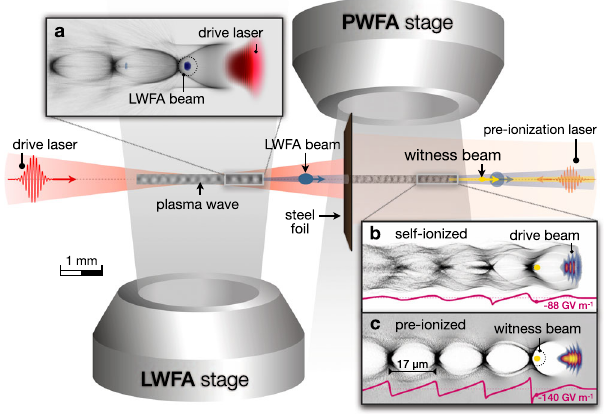
Fig. 1 Schematic overview of the experiment. Two consecutive gas jets form the basis of an LWFA-driven PWFA. A high-intensity laser pulse (red) drives an LWFA in the fi rst stage, generating a high peak-current electron beam (blue). The spent LWFA laser is re fl ected by a thin steel foil, whereas the electron beam propagates into the second stage, acting as the PWFA driver. In the PWFA stage, a witness beam (yellow) is accelerated. In addition, a counter-propagating low-power laser pulse can be applied for generating a pre-formed plasma channel in the PWFA stage prior to the drive beam arrival. a Illustration of a plasma wave driven by the high- intensity laser, with electron density in gray. b Plasma wave generated by the LWFA electron beam in the self-ionized PWFA regime. c Excited plasma wave in the pre-ionized PWFA regime. Images shown in a , b , c are obtained from simulations using the code OSIRIS. The purple line in b and c represents the longitudinal electric fi eld on axis, considering only the interaction of the drive beam with the second gas